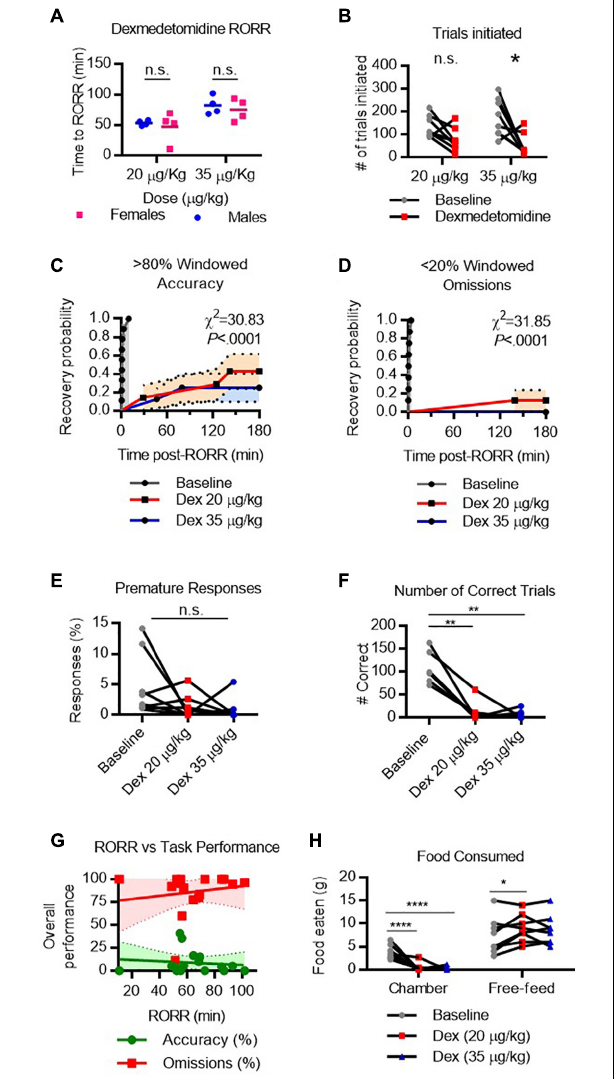
FIGURE 7 | Performance on the 5-CSRTT following dexmedetomidine. (A) Return of righting reflex (RORR) following 20 µ g/kg and 35 µ g/kg dexmedetomidine (infused over 10 min, I.V.) in male and female rats. (B) Total number of 5-CSRTT trials initiated at baseline and following dexmedetomidine anesthesia. (C,D) Probability of achieving > 80% windowed accuracy (C) and < 20% windowed omissions (D) at baseline and following dexmedetomidine by the indicated time. (E) Percent of premature responses at baseline and following dexmedetomidine. (F) Total number of correct trials at baseline and following dexmedetomidine. (G) RORR latency vs. overall accuracy (green) and omission (red) performance following dexmedetomidine anesthesia. Regression slope (solid line) and 95% confidence interval (dashed lines) indicated. (H) Total weight of food eaten in the chamber during the task and following the task during the free-feeding period at baseline and following ketamine. n.s., not significant; * P < 0.05, ** P < 0.01, **** P < 0.0001, N =